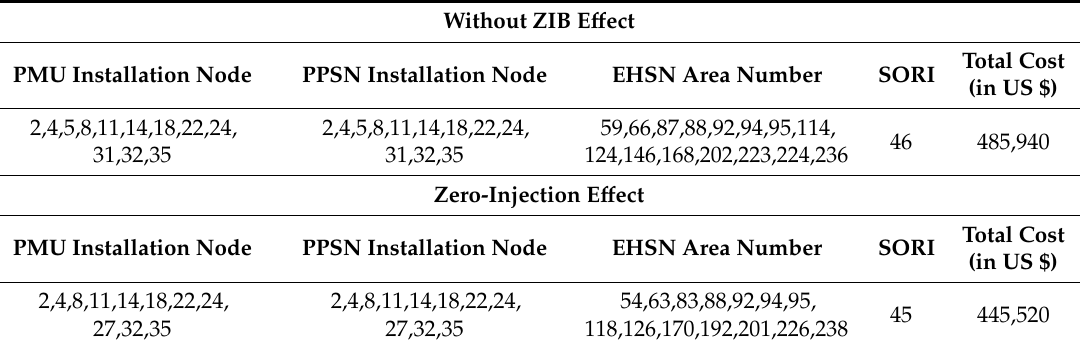
Table 6. Optimization problem